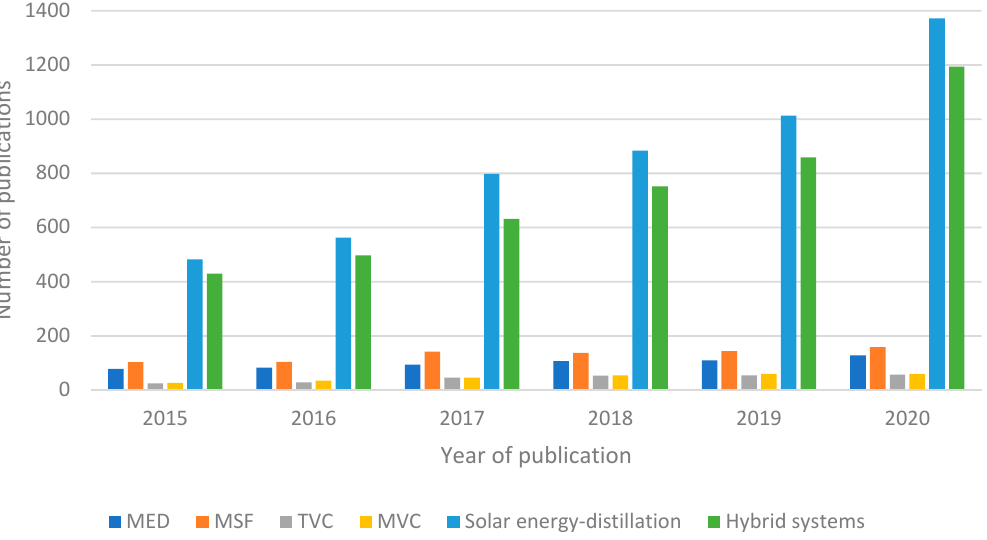
Figure 5. Number of publications on thermal desalination technologies (2015–2020).